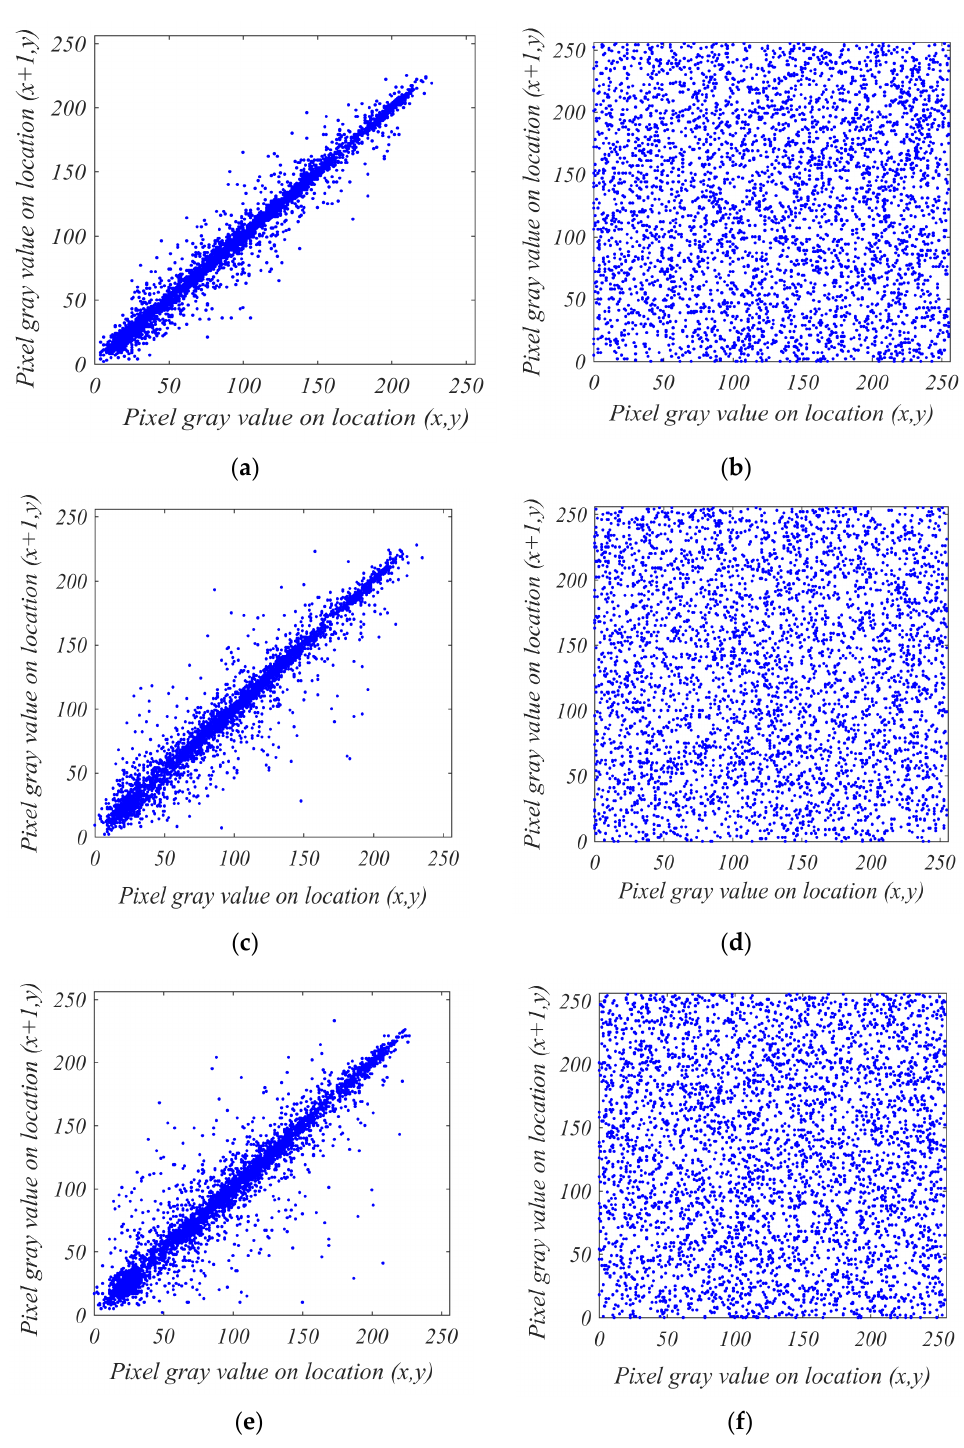
Figure 20. Correlation distribution between two adjacent pixels of original Lena image and its corresponding encrypted image: ( a , b ) vertical correlation; ( c , d ) horizontal correlation; ( e , f ) diagonal correlation.